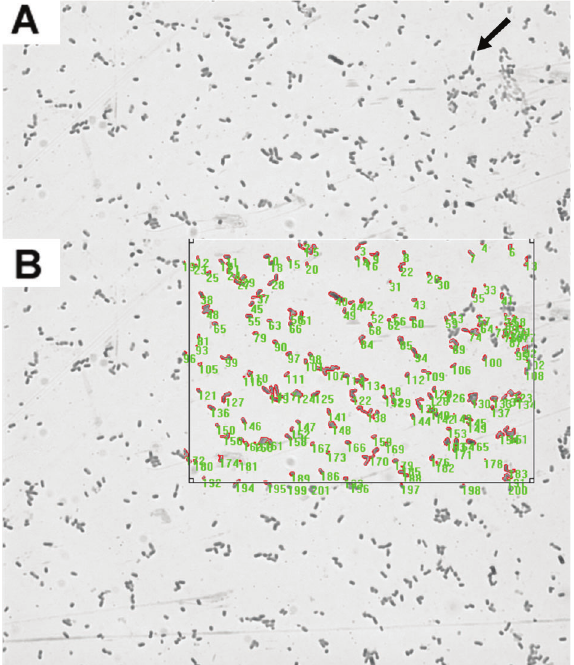
Figure 1. Representative image of bacterial fi lamentation in an AB1157 culture in the exponential growth phase. A , The arrow indicates bacterial fi lamentation; B , inset shows how image analysis was performed. A bacterial fi lament was considered present when the area of a bacterial cell was larger than 2.5 times the mean area of bacterial cells.